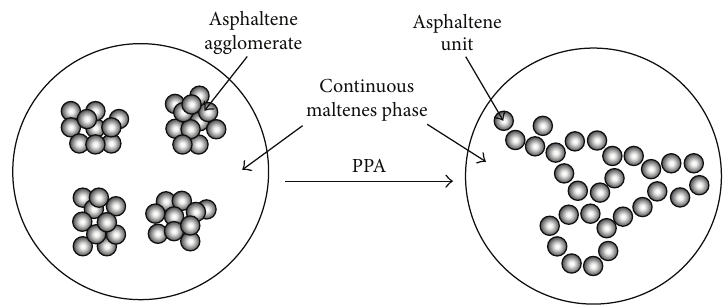
Figure 1: Influence of PPA on the colloidal structure of bitumen (adapted from [17]).